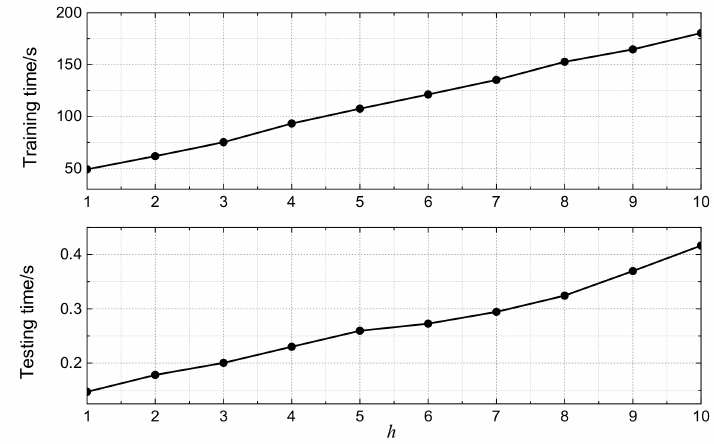
Figure 8. Time complexity, with h ranging from 1 to 10 in the 5-min ahead prediction